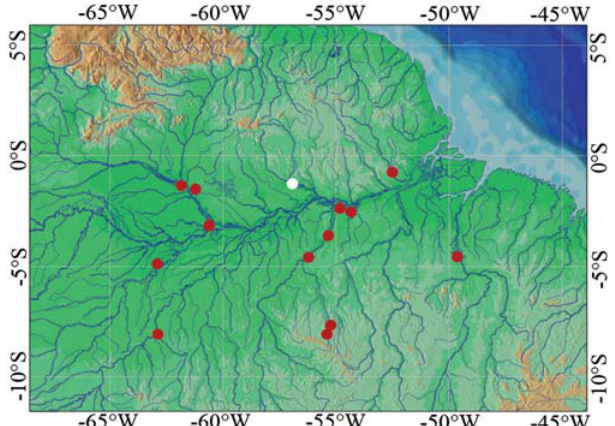
Fig. 3. Distribution map of Anchoviella juruasanga . Holotype indicated by white circle; paratypes and non-type material indicated by red